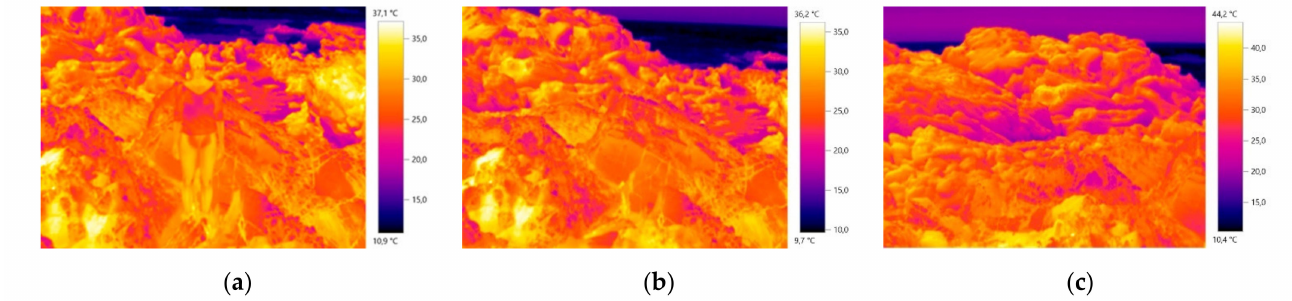
Figure 1. Thermal images of the base of the conceptual process of the diurnal prototype: ( a ) with the presence of the human body; ( b ) and ( c ) with the absence of the human body.